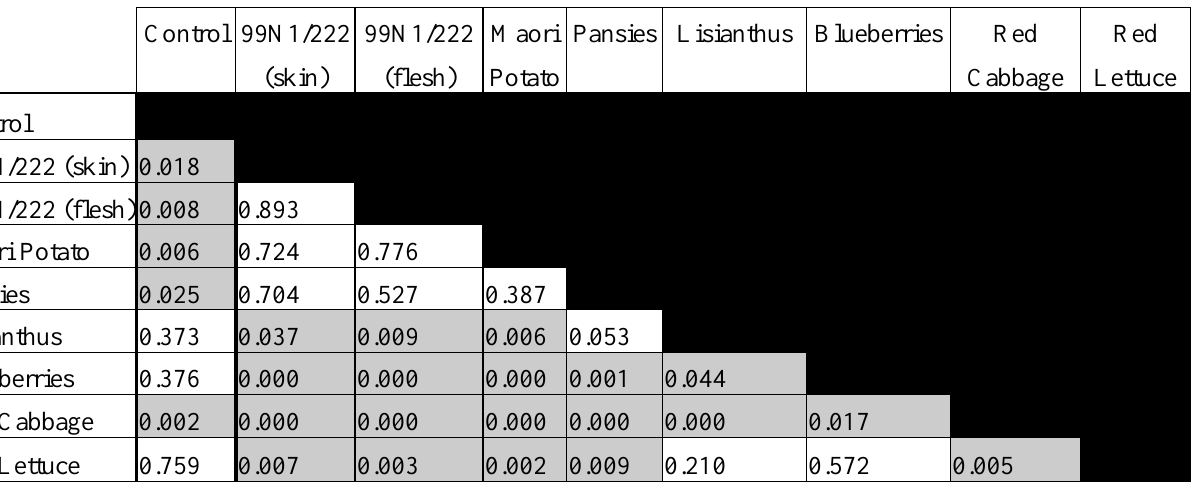
Table 3. P-values determined from unpaired t-tests for tail extent moment in the 0 ºC H treatment group. Shaded boxes represent significant differences (p 